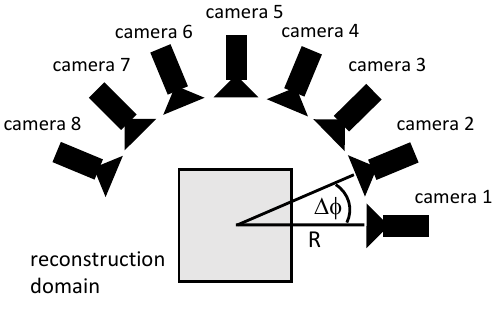
Figure 4. Camera setup (8